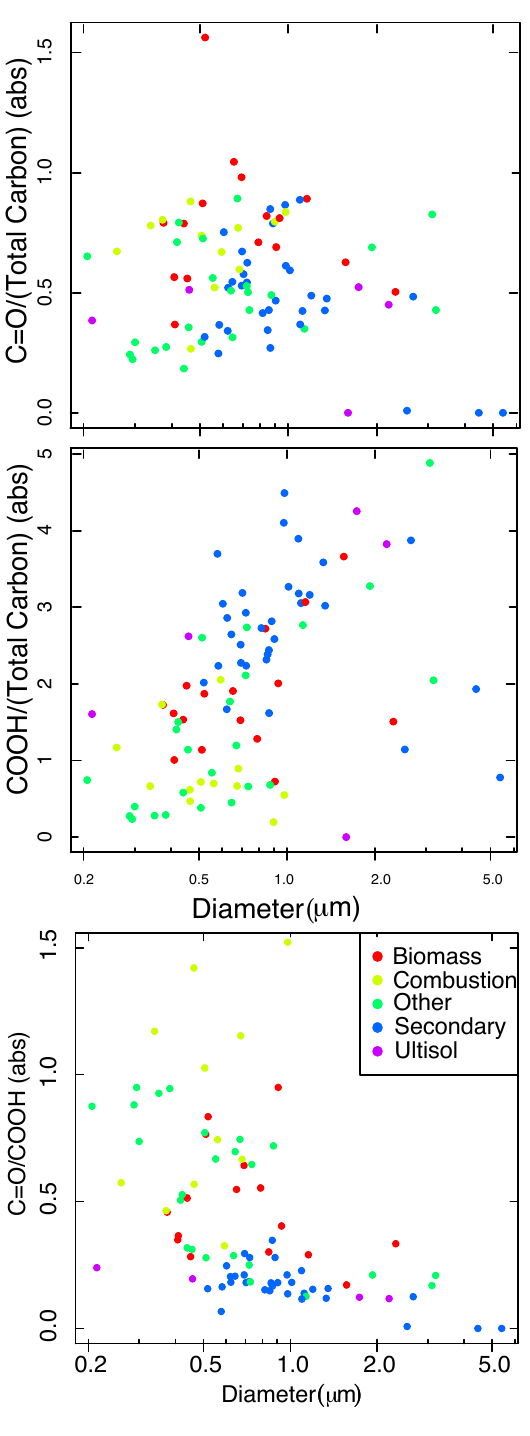
Fig. 7. Summary of ketone groups and carboxylic acid groups, for individual particles measured by STXM-NEXAFS, as a function of the apparent geometric diameter after impaction on the